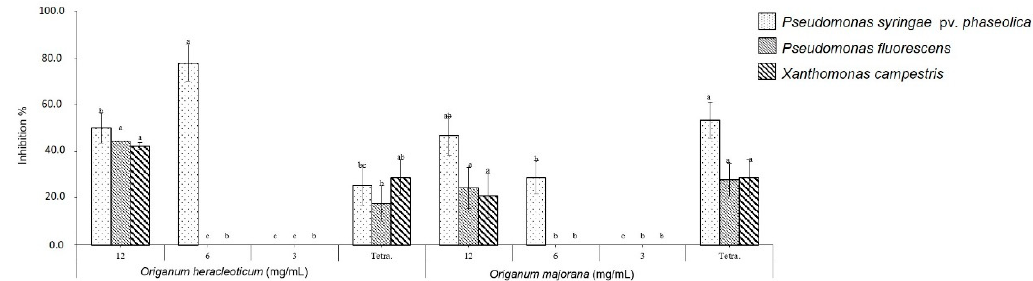
Figure 3. Antibacterial activity of O. heracleoticum and O. majorana EOs against G-ve bacteria. Bars with di ff erent letters for each tested bacteria indicate mean values significantly di ff erent at p < 0.05 according to the Tukey B test between di ff erent tested concentrations. Data are expressed as mean ± SDs.